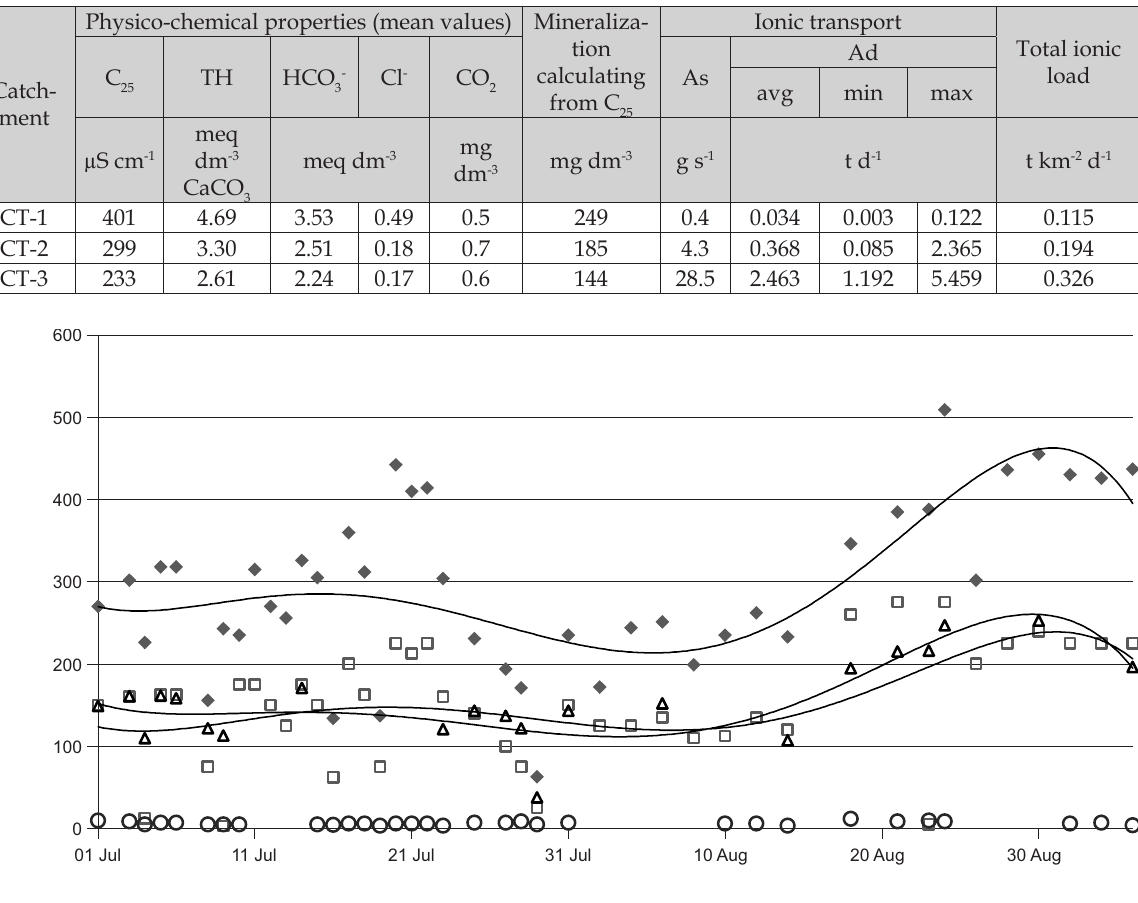
-, and total hardness (TH) in streams of CT-2 catchment 3 in the period 1.07–5.09.2014